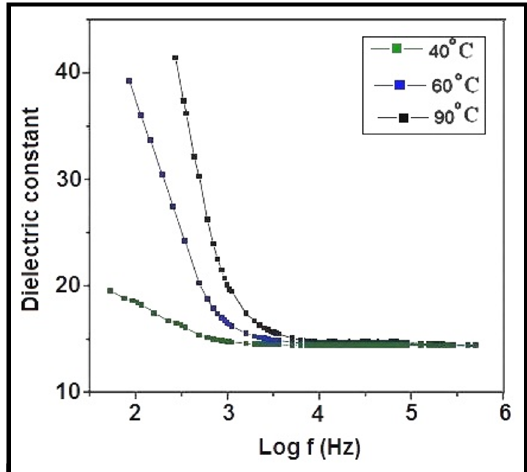
Fig.6. Dielectric constant of TiO